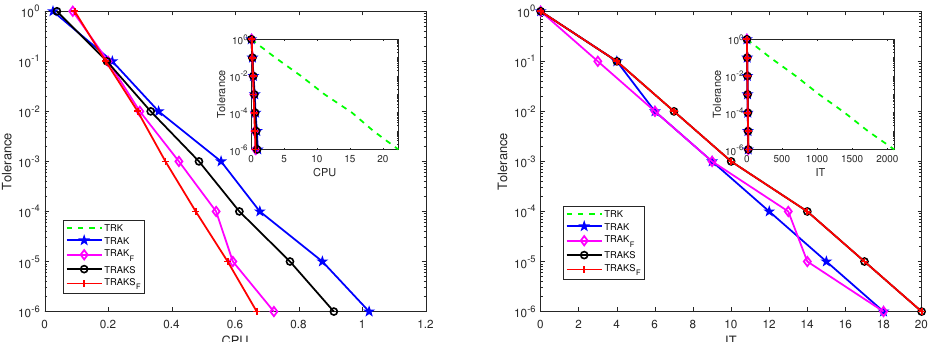
Figure 6. Pictures of tolerance versus IT and CPU times for the TRK, TRAK, TRAK F , TRAKS, and TRAKS F algorithms when X comes from the 3D MRI image data set.